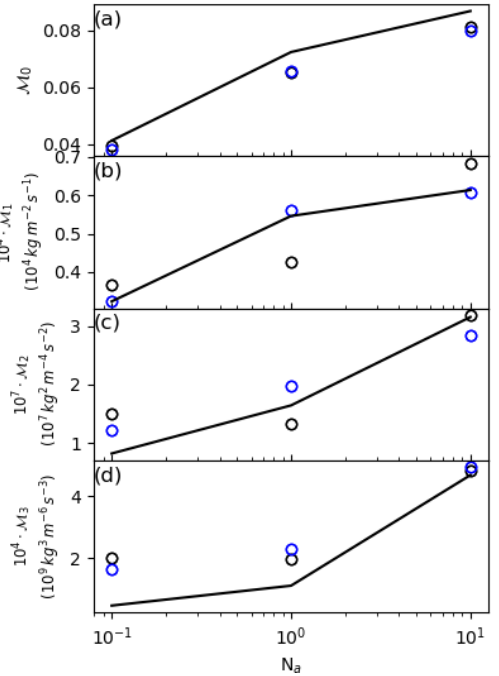
Figure 7. The simulated (lines) and predicted (circles) bulk-rainfall characteristics as functions of the (normalised) aerosol concentra- tions, N a , for the three model experiments: (a) mean rainfall fre- quency; (b) the mean rainfall amount, scaled by 10 4 for presenta- tional convenience; (c, d) the second and third moments of the rain- fall frequency distributions. The blue and black circles are double- moment and single-moment predictions,